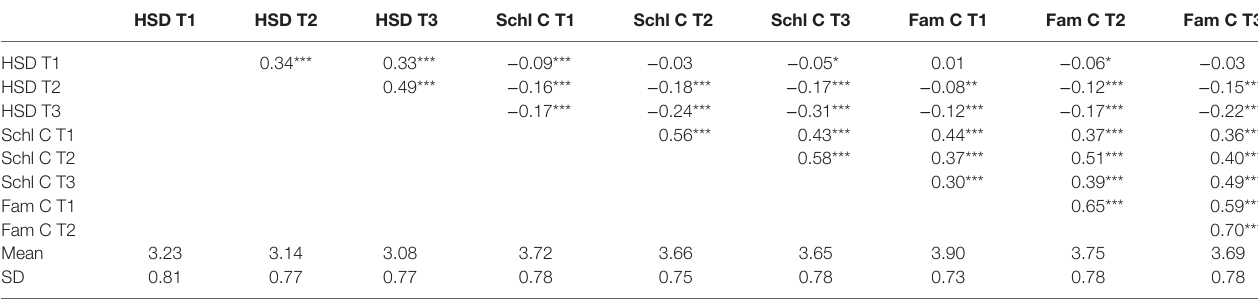
Table 1 | Descriptive statistics for HSD, family connectedness, and school connectedness over the three times of measurement. hsD T1 hsD